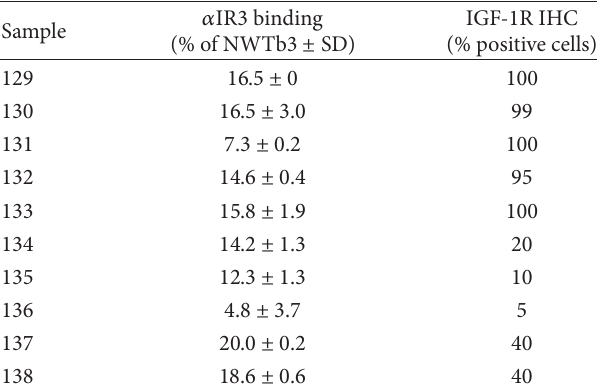
T 2: ELISA and IHC quanti�cation of IGF-1R in patient tumor